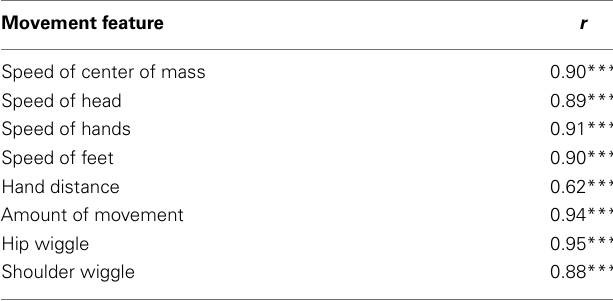
Table 1 | Results of the intraclass correlations for each of the movement features.